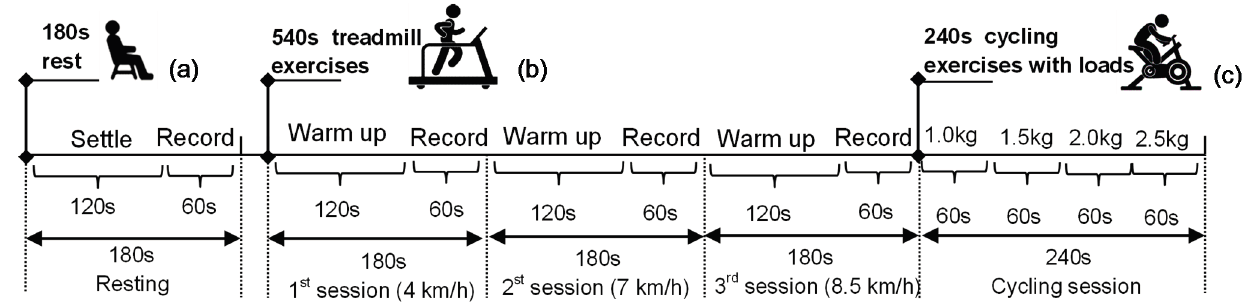
Figure 9. The illustrated protocol implementation of ( a ) resting on the chair with a period of 180 s; ( b ) walking and running on treadmill with an execution period of 540 s; and ( c ) cycling exercise with loads implemented in period of 240 s.